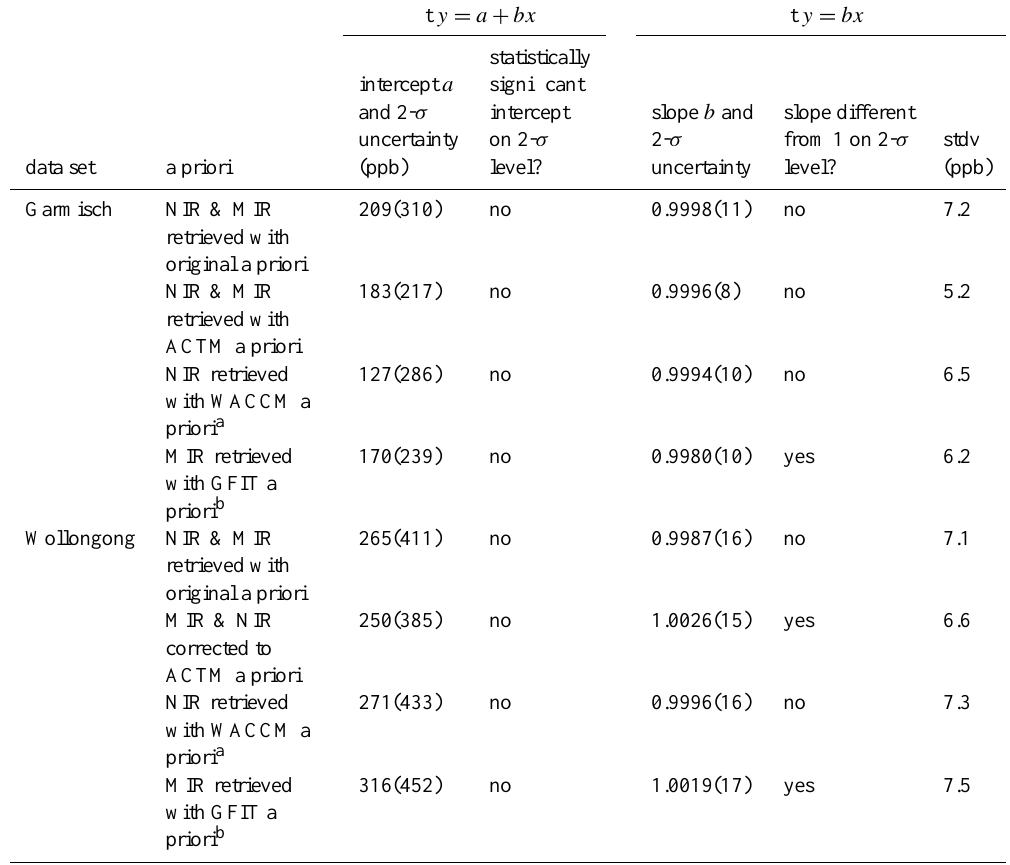
Table 5. Intercept and slope of linear scatter plot fits between multi-annual data sets of NIR and MIR XCH 4 retrievals using varied a priori profiles. Data are monthly means constructed from same-day measurement